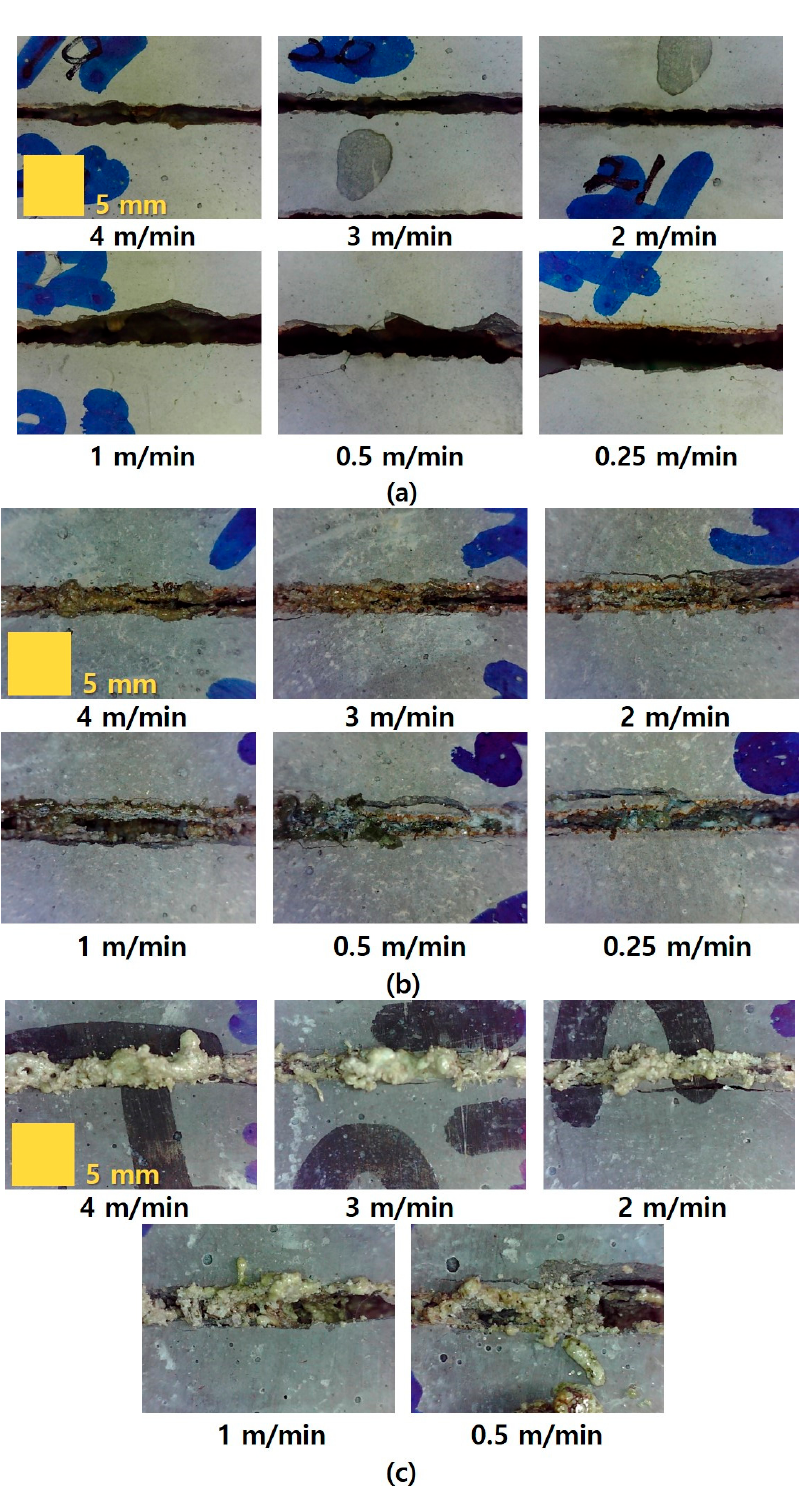
Figure 3. Examples of specimen surfaces after laser interaction: ( a ) LP 0.25, ( b ) LM 0.25, and ( c ) LU- Ⅰ .